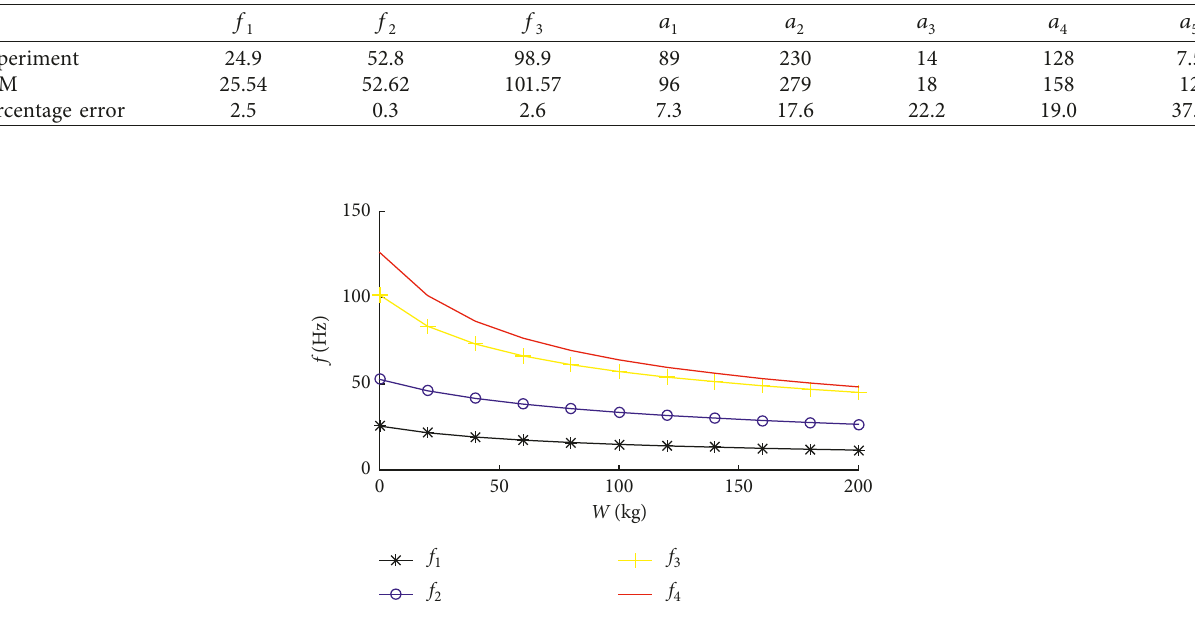
Figure 6: Variation of the first four natural frequencies with load weight.